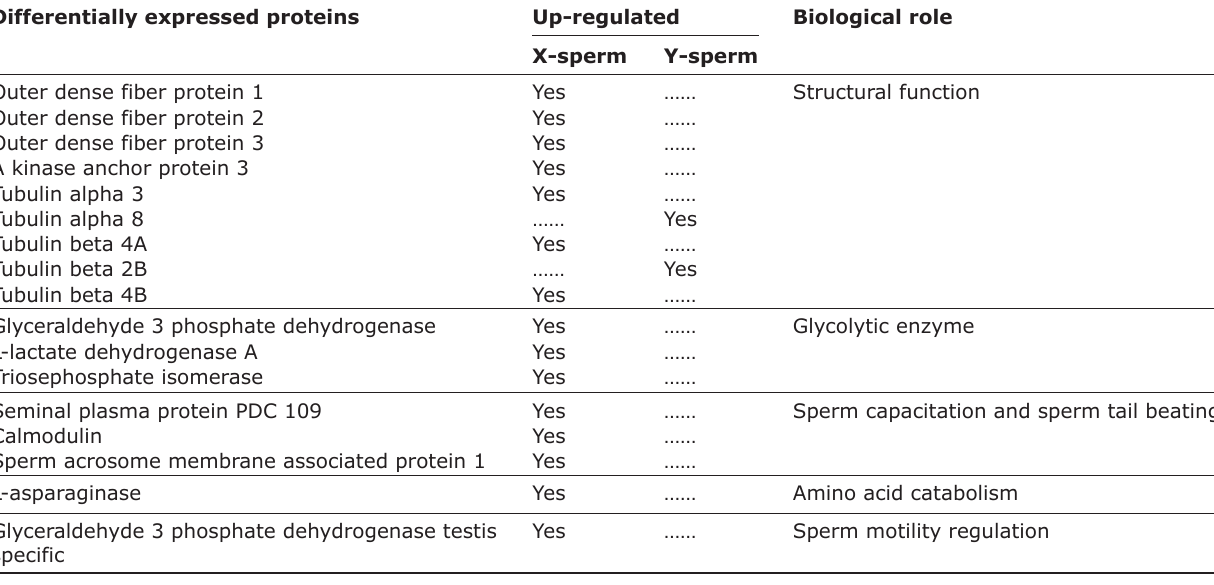
Table-1: Differentially expressed proteins in sexed sperm (adapted and modified from De Canio et al . [1]). Differentially expressed proteins